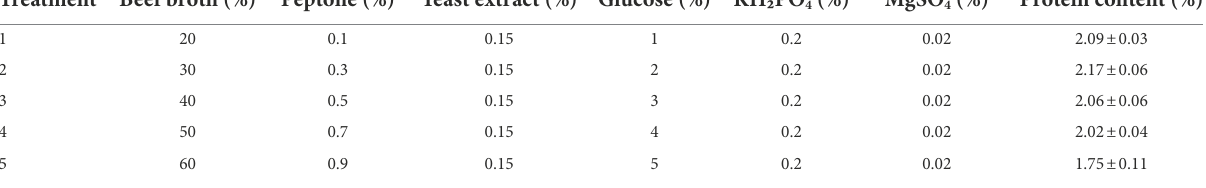
TABLE 3 Design and results of steepest ascent method. Treatment Beef broth (%) Peptone (%)